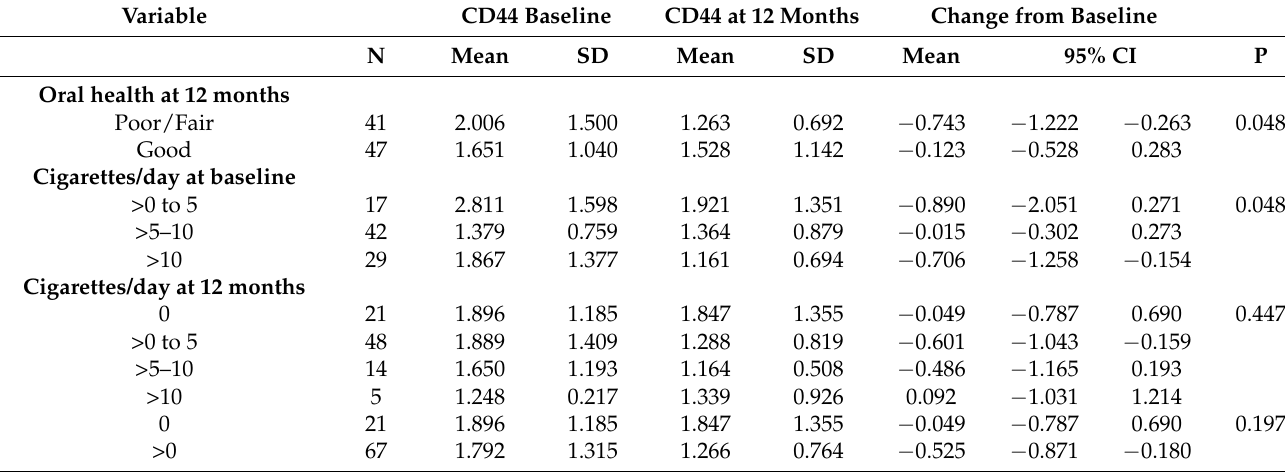
Table 3. Selected changes in solCD44 levels at 12 months following a smoking cessation program.